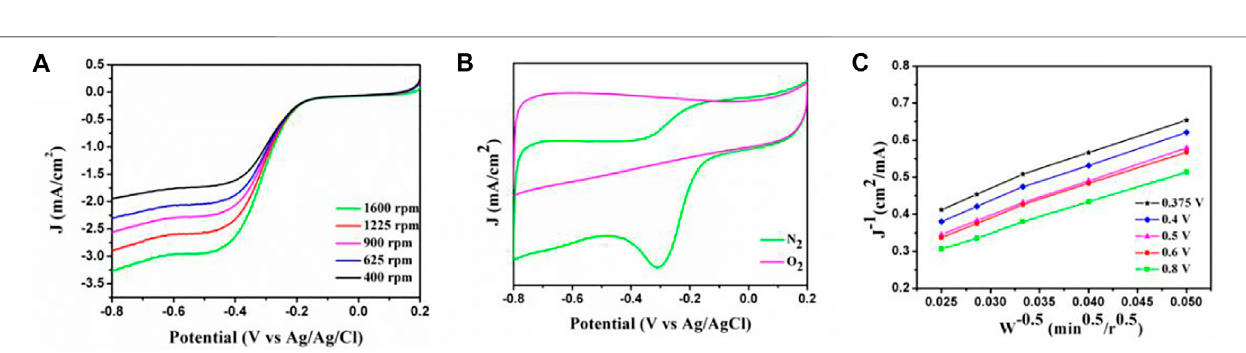
FIGURE 9 | (A) LSV and (B) CV curves of the samples prepared with F127 in 0.1 M KOH aqueous electrolyte (scan rate: 50 mV s − 1 ); (C) K-L plots of the samples prepared with F127 derived from LSV curves at different electrode potentials.